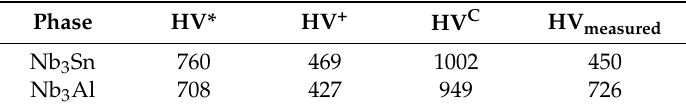
Table 1. Vickers hardness (HV) (kgf/mm 2 ) of unalloyed Nb 3 X (X = Al, Sn). The HV*, HV + and HV C